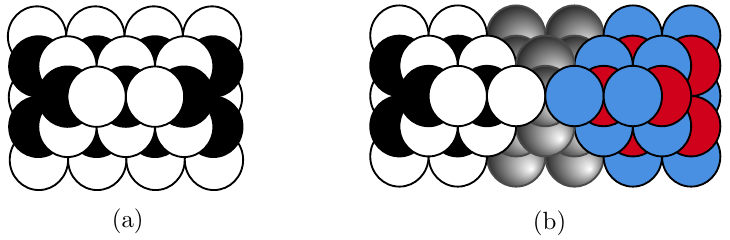
Figure 10 . (a) The crystal for C 1 for the conifold C . (b) “Merging” two such copies. Here, we still stay in the case C , but with a different chamber. Each copy gives M ( x ) 2 f M Q q ) M ( Q q ; 2) . After merging the shaded pyramid (where the colours are f M ∧ (2) := M ( i , x ∧ i , x ignored), we reach the chamber C with partition function M 2 f M 3 identified with the white (black)